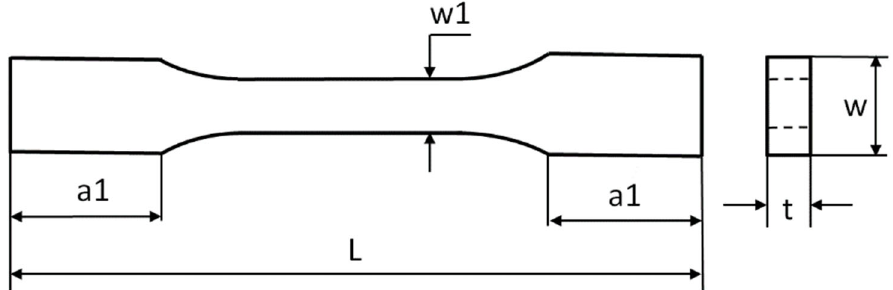
Figure 3. Dimensions of the sample subjected to